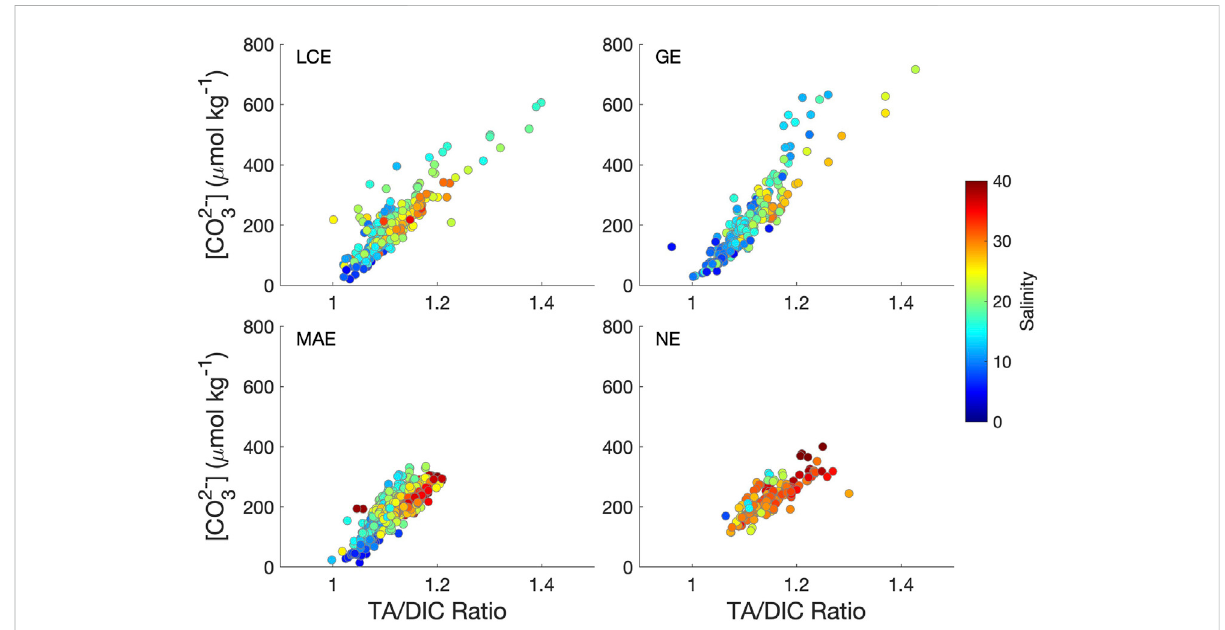
FIGURE 9 Carbonate ion concentration vs. TA/DIC ratio inthefour studied nwGOM estuariesduring 2014 – 2018. Samples with S < 5werenot included as thecarbonatedissociation constants are validfor salinity 5 – 45(Waters etal.,2014).The r 2 valuesfor these regressions are 0.76(LCE),0.82 (GE),0.68 (MAE), and 0.69 (NE).